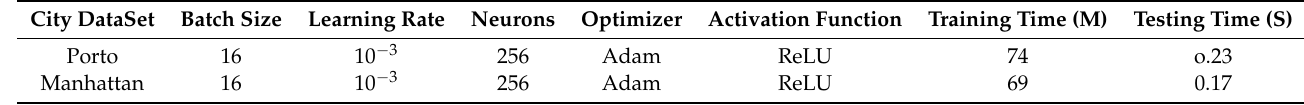
Table 2. Hyperparameter setting and training